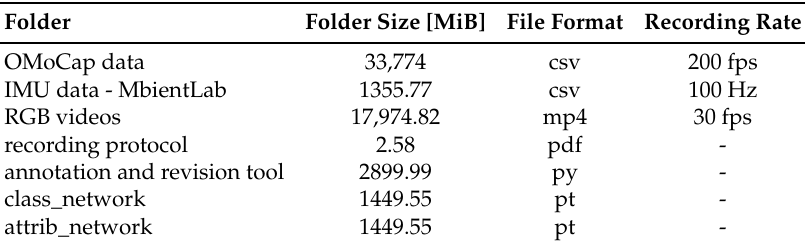
Table 8. Folder overview of the LARa